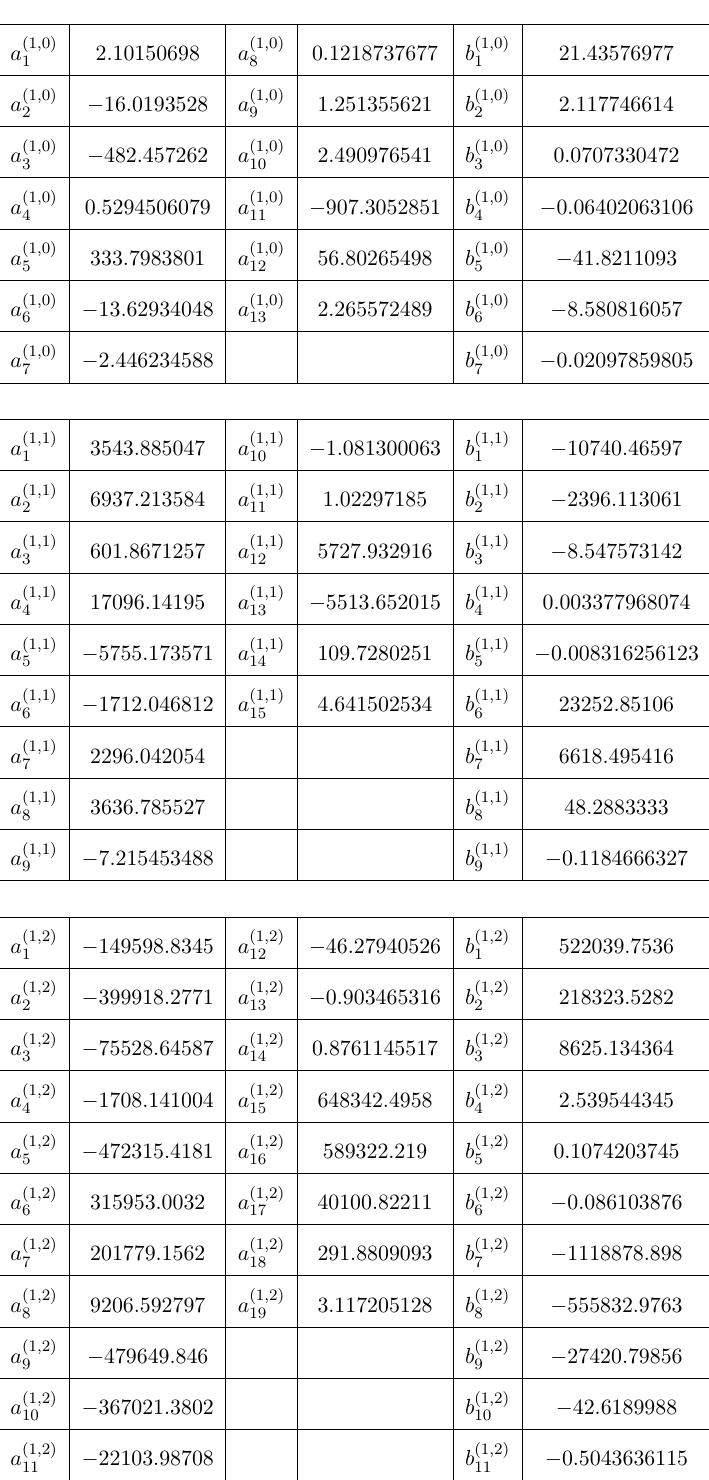
Table 1 . Coe(cid:14)cients of the (cid:12)t functions F (1 ;j ) for j = 0 ; 1 ; 2.